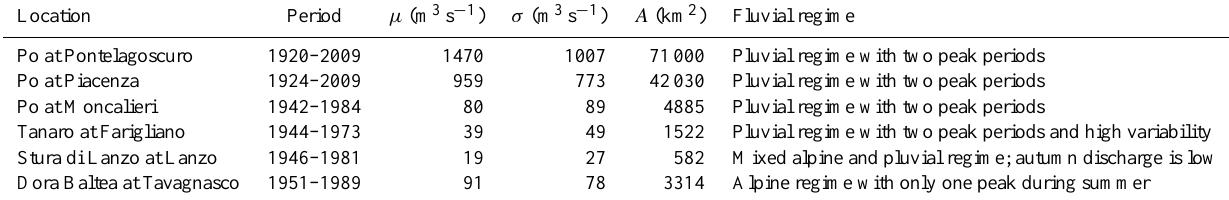
Table 1. Observation period, mean value µ and standard deviation σ of the observed time series, along with the catchment area A at the considered location and the dominant fluvial regime according to the Po River Basin Authority (2006).